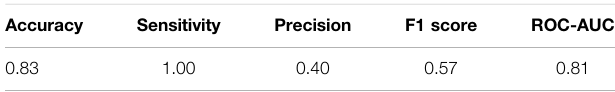
TABLE 5 | Prediction performance for 20